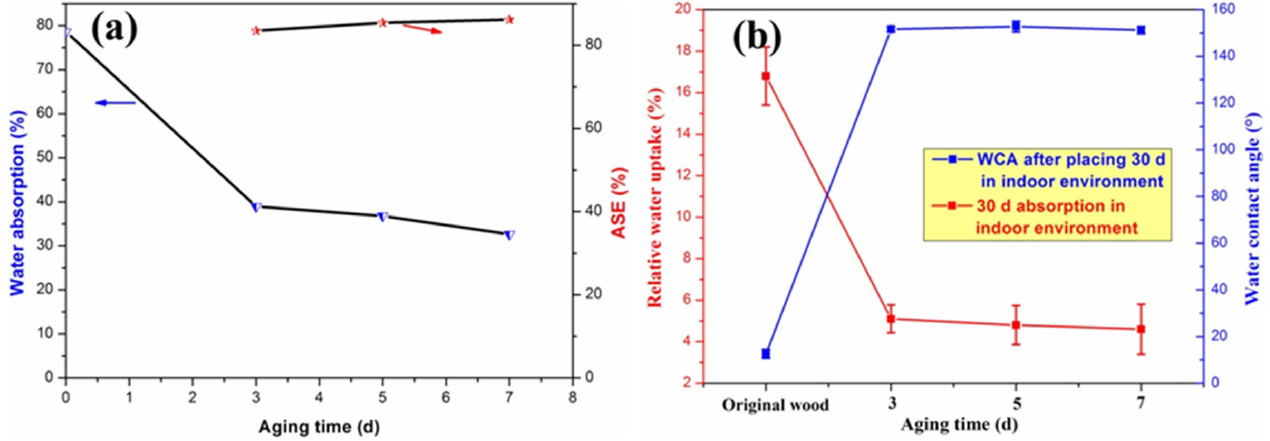
Figure 9. ( a ) The tests of 24 h of water absorption and the ASE; ( b ) 30 d water absorption rate and WCA value of the original and SiO 2 /PMHOS ‐ modified wood in an indoor environment.